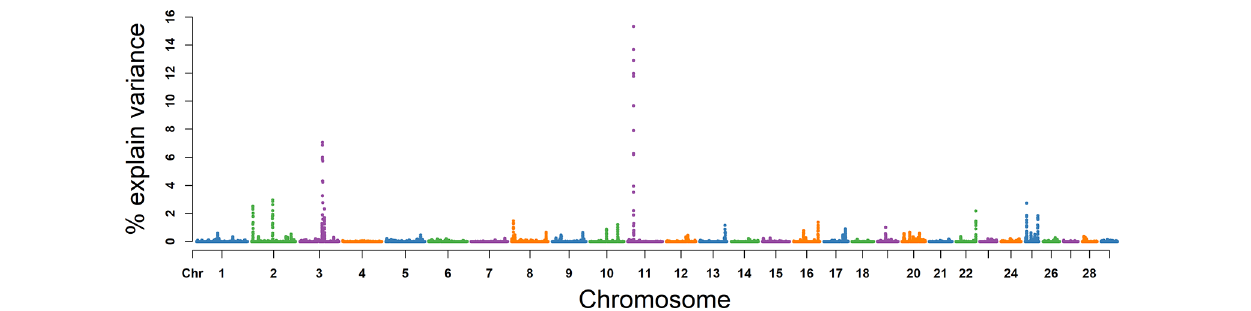
FIGURe 5 | GWAS results of sperm concentration (SC) in Holstein bulls of China. Each dot represents one SNP. The X-axis represents 29 autosomes, respectively. The Y-axis represents the percentage of the explained variance by SNP.